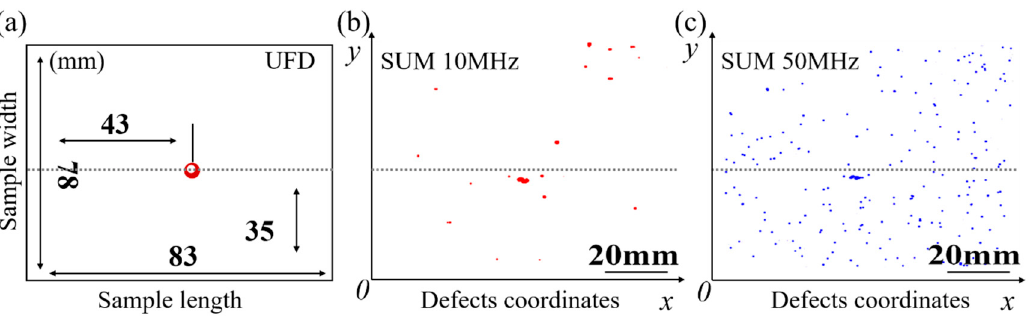
Figure 4. Scanning results of different types of ultrasound methods: ( a ) ultrasonic flaw detector, 2.5 MHz; ( b ) scanning ultrasonic microscope, 10 MHz; ( c ) scanning ultrasonic microscope, 50 MHz.